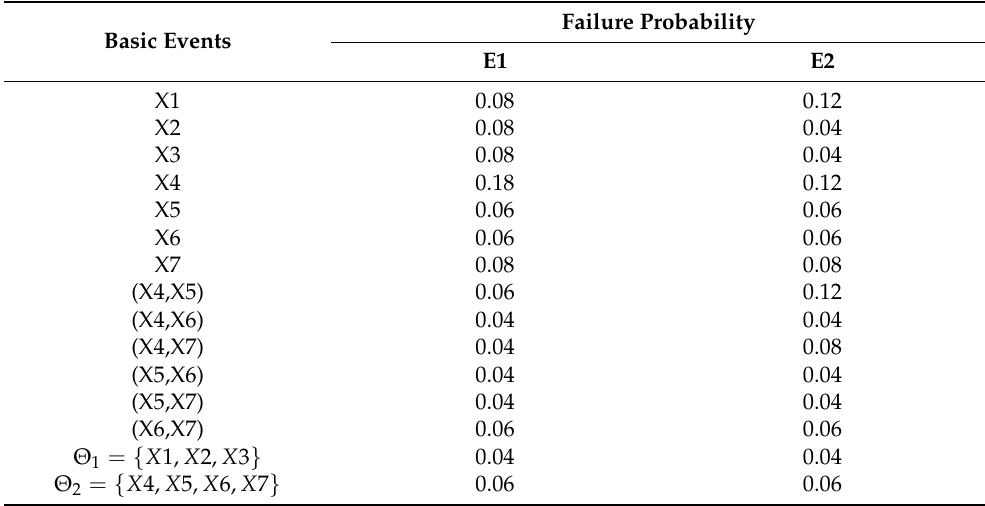
Table 3. Failure rate of basic